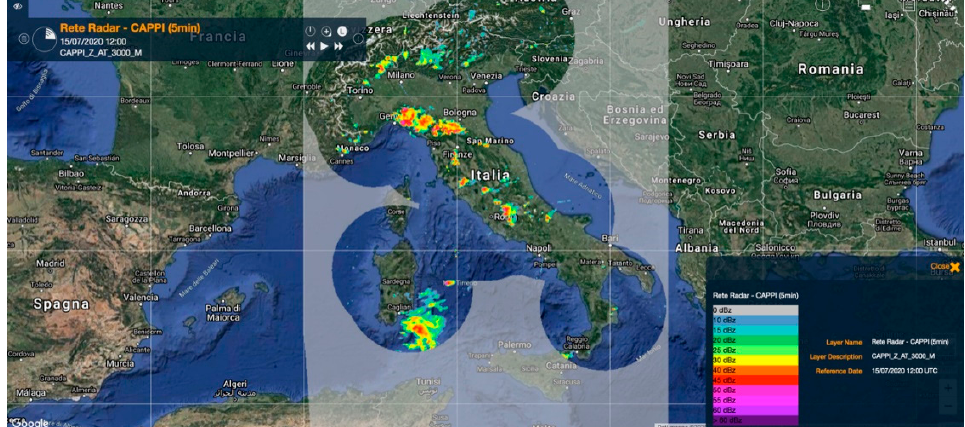
Figure 5. CAPPI (Constant Altitude Plan Position Indicator) radar measurement at 3000 m of 15 July 2020 12:00 UTC. Most of Sicily is covered by a light grey, which corresponds to missing data. Image obtained from my DEWETRA platform, courtesy of the Italian Civil Protection Department.